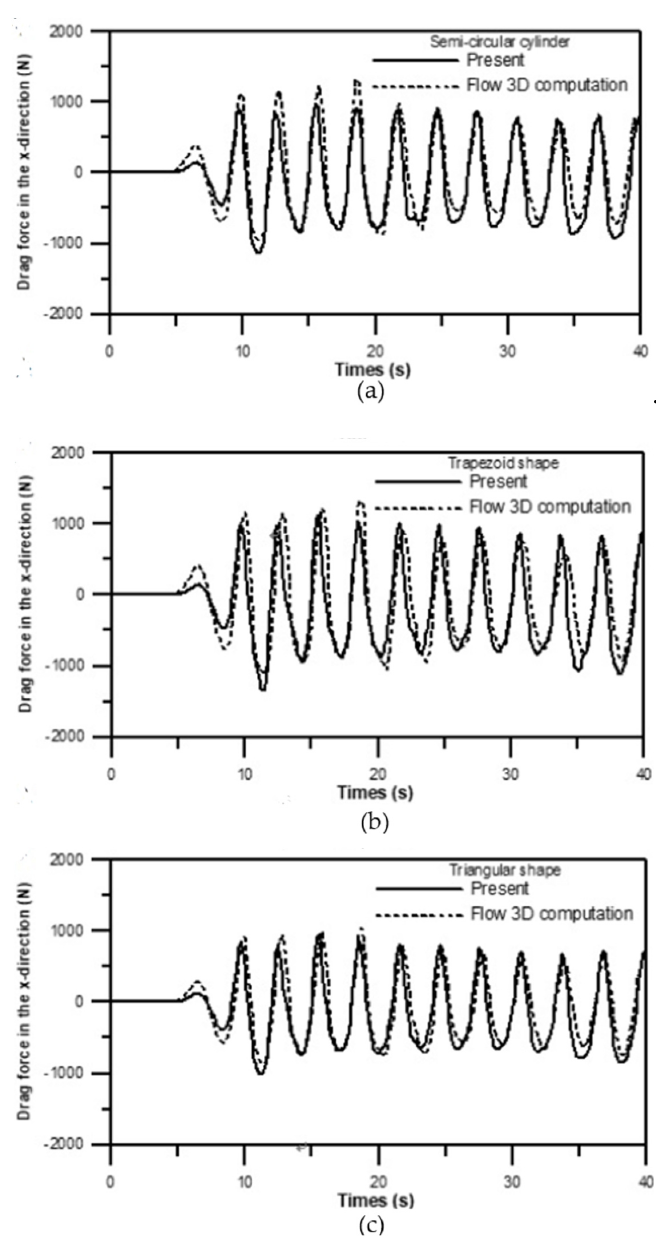
Figure 15. Periodic variation of the drag forces for the progressive waves with H i = 0.2 m and T = 3 s over the breakwaters for the type of ( a ) semicircle, ( b ) trapezoid, ( c ) triangular. The drag and lift forces with the incident wave period T = 4 s are demonstrated in Figure 17.